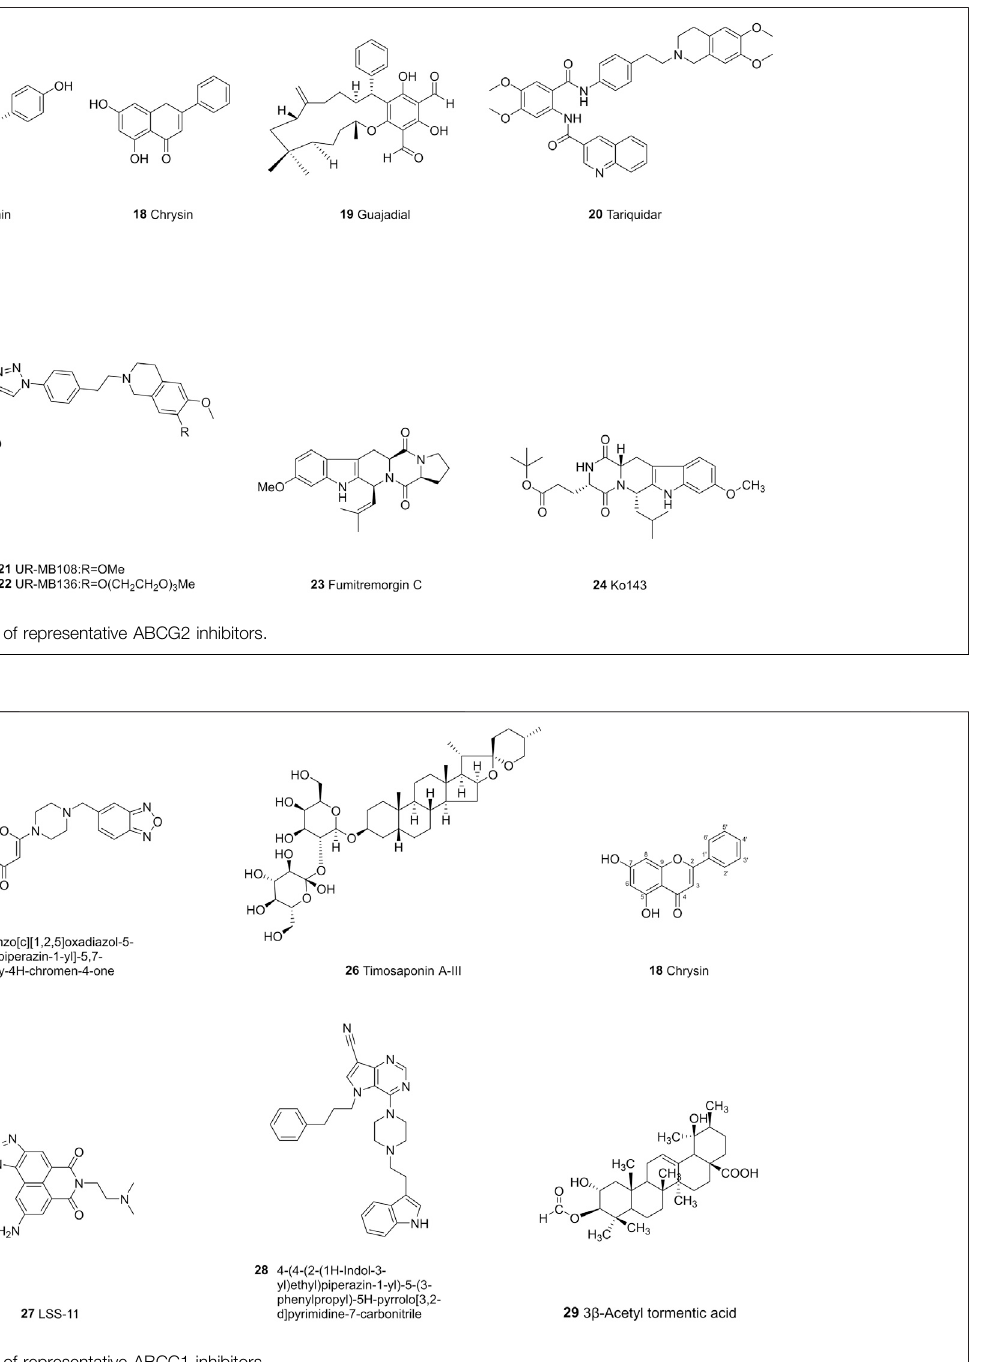
FIGURE 6 | The chemical structures of representative ABCC1